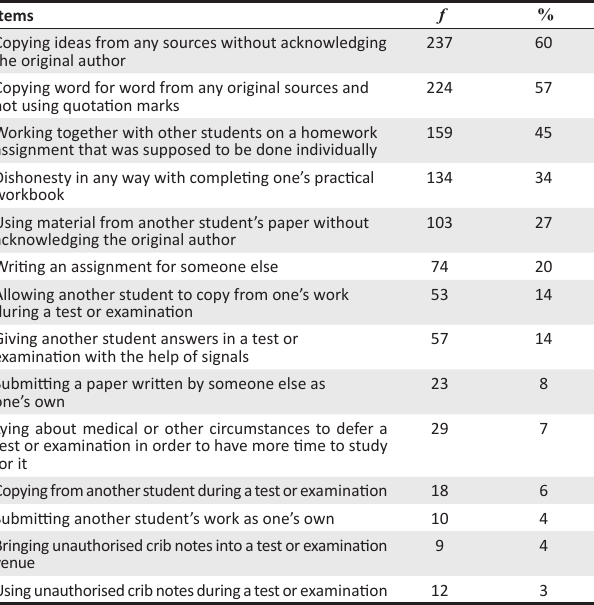
TABLE 1: Incidence of cheating behaviours .